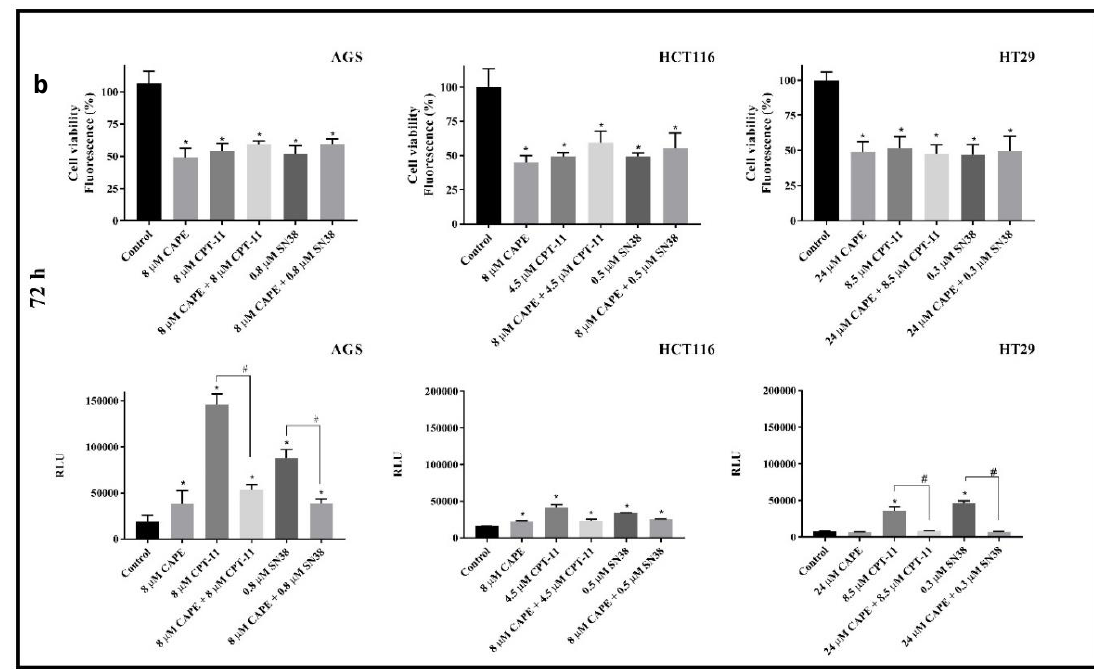
Figure 5. Viability and caspase-3 / 7 activity after 24 h ( a ) and 72 h ( b ) of exposure on CAPE, CPT-11, CAPE + CPT-11, SN38 and CAPE + SN38 in AGS, HCT116 and HT29 cell line (mean ± S.E.M). * p < 0.05 as compared with control (untreated) cells; # p < 0.05 as compared with cells treated drug.